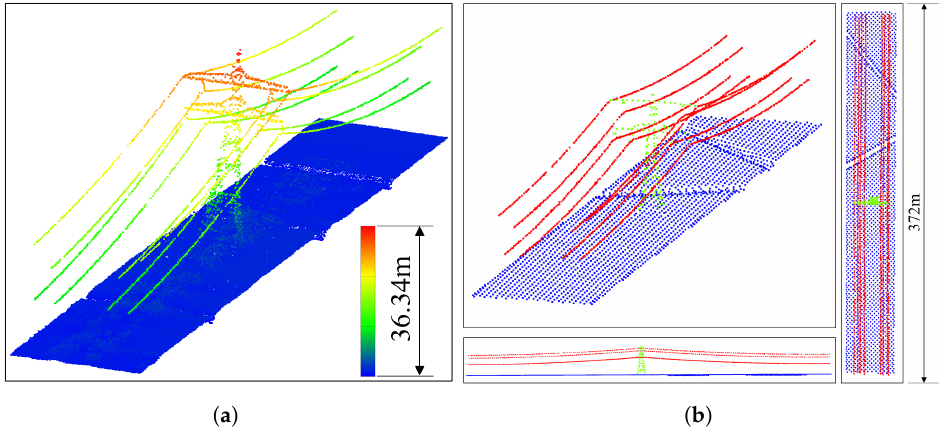
Figure 21. ( a ) High-voltage powerline scenario; ( b ) pre-processing